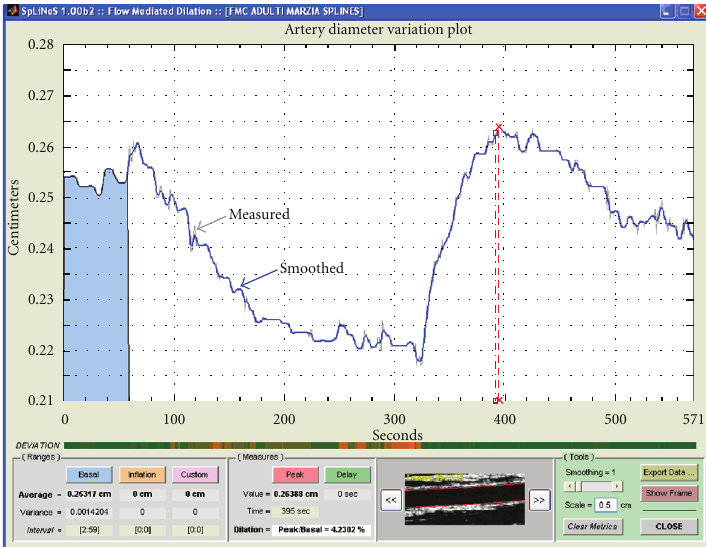
Figure 11: FMD data. Thin line: artery diameter as a function of frame index. Thick line: artery diameter after smoothing. Red line: frame